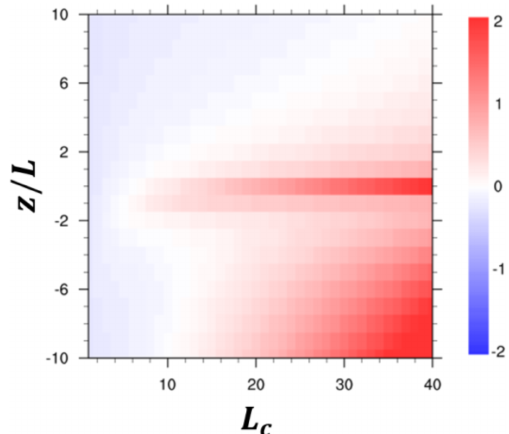
Figure 5. Roughness length difference (m) between offCTL and offRSL (offRSL–offCTL) at given atmospheric stability ( z/L ) and penetration depth ( L c